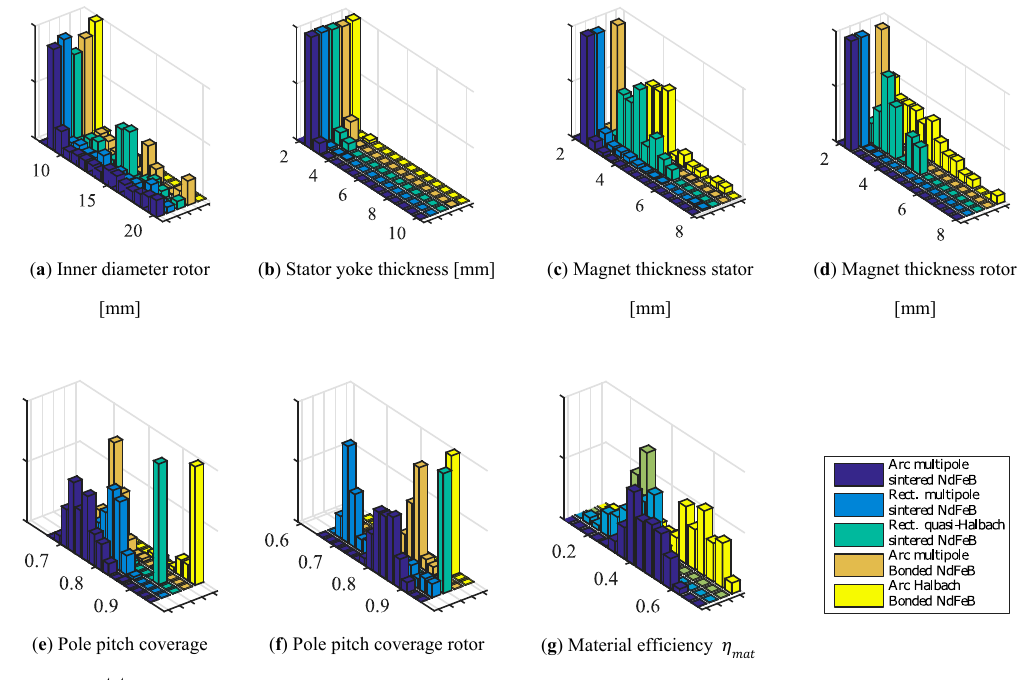
Figure 11. Optimal parameters histograms for five selected stator and rotor topologies selected after design space pruning.